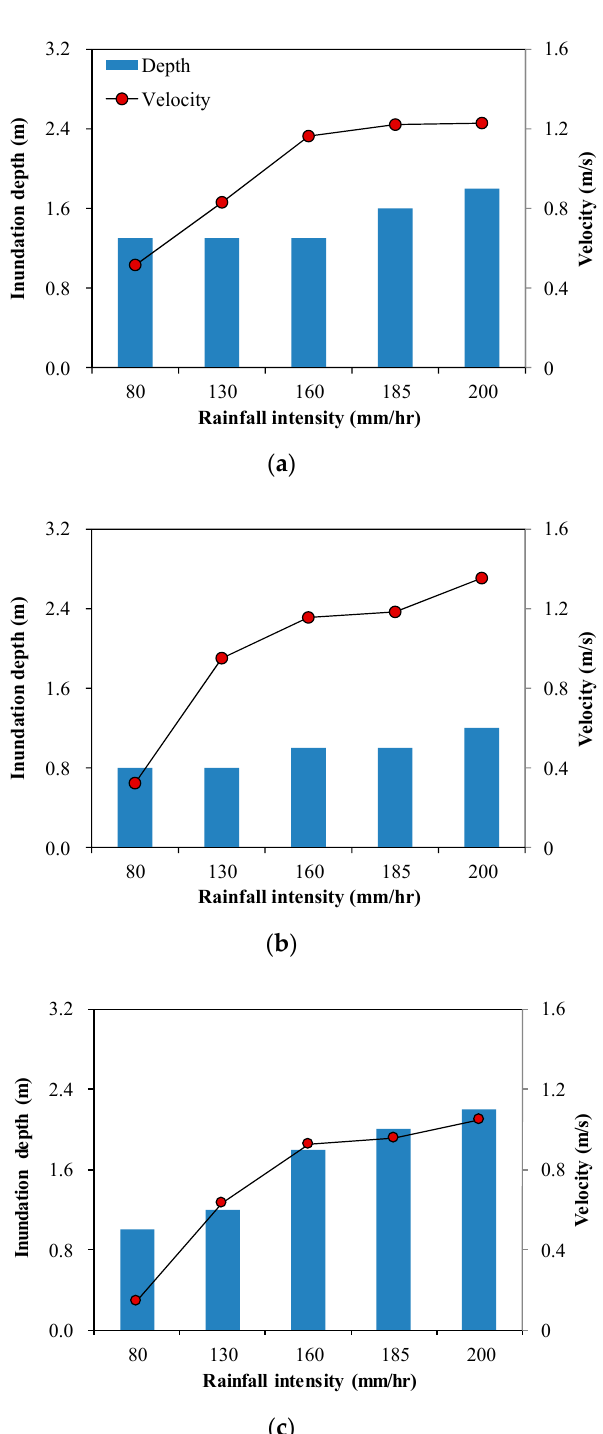
Figure 8. Velocity and inundation depth against rainfall intensity: ( a ) point A; ( b ) point B; ( c ) point C.